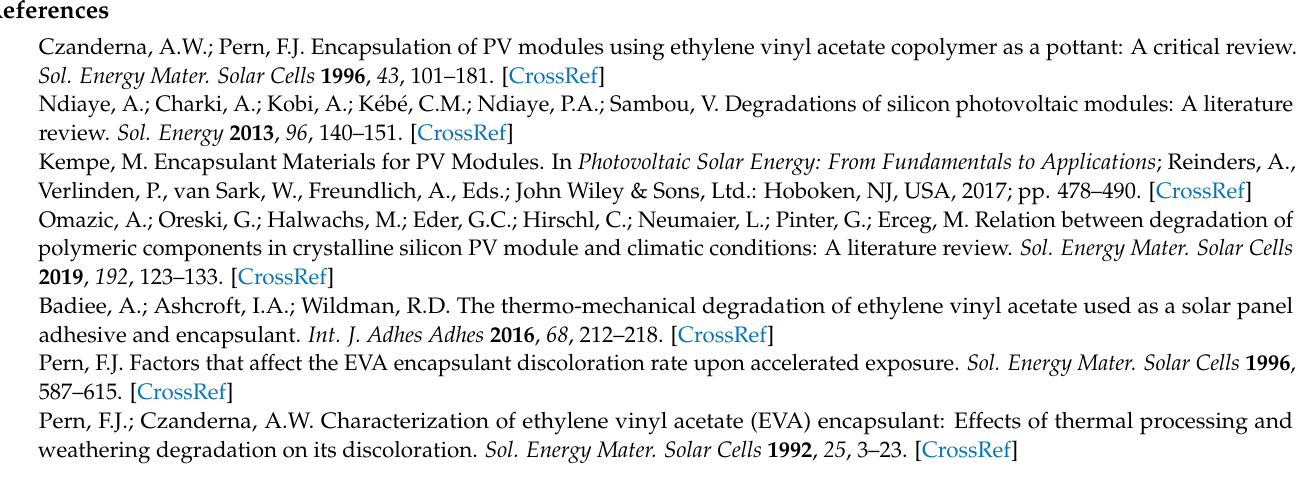
Figure S3: Chromatograms of POE samples exposed to DH test (left) and UV test (right); Figure S4: Mass spectra of the additives detected by means of